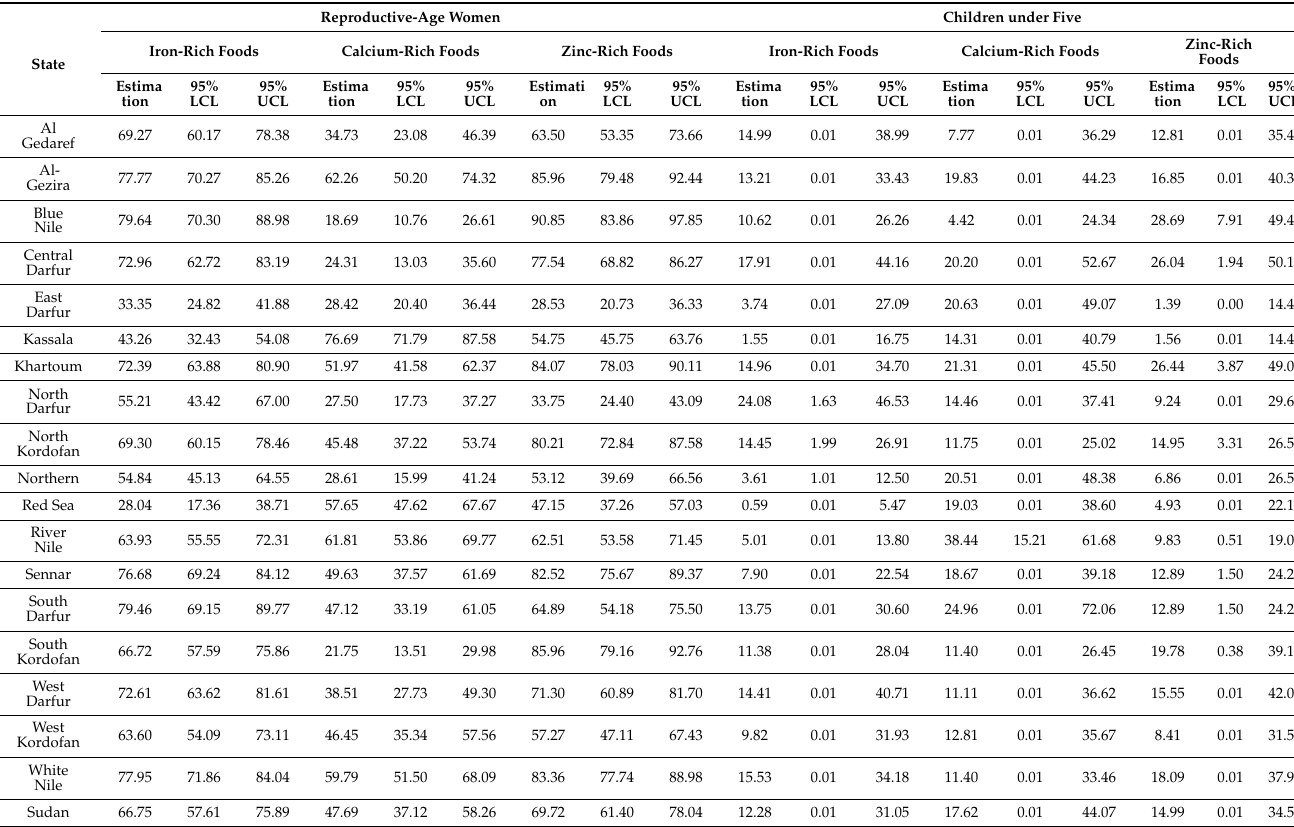
Table 5. Consumption of minerals-rich foods among reproductive-age women (15–49 years of age) and their children. Reproductive-AgeWomen ChildrenunderFive Iron-RichFoods Calcium-RichFoods Zinc-RichFoods Iron-RichFoods Calcium-RichFoods Zinc-Rich State